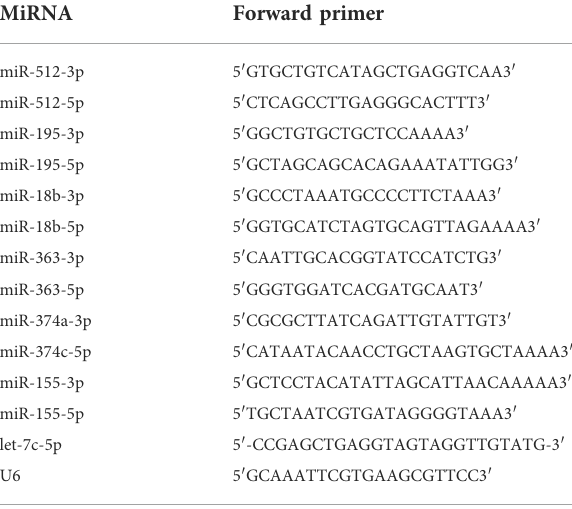
TABLE 2 miRNA primer sequences used for